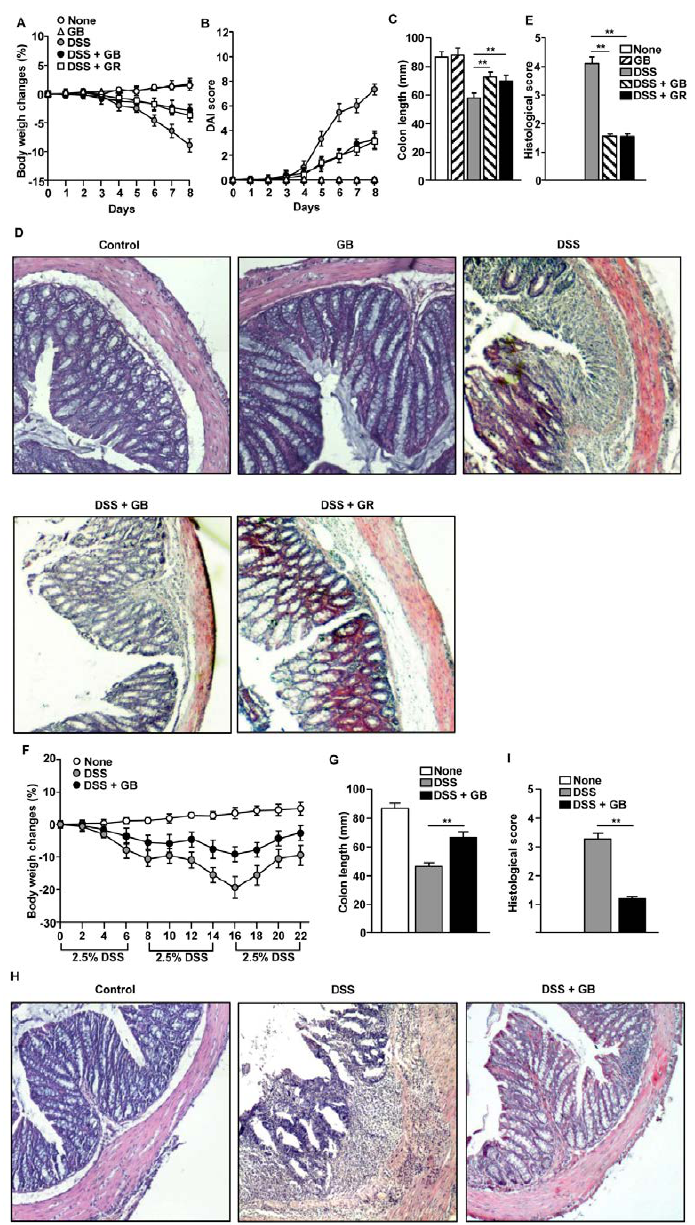
Figure 1. Ginseng berry extract (GB) treatment attenuates DSS-induced colitis. ( A to E ) Dextran sodium sulfate (DSS; 3%) was added to the drinking water of C57BL/6 mice and the mice were orally treated with GB, ginseng root extract (GR) or 0.9% saline for eight days. ( A ) Body weight changes in control (no treatment), GB, DSS, DSS + GB, and DSS + GR groups ( n = 9); ( B ) The disease activity index (DAI) was scored using stool consistency, the presence or absence of fecal blood, and weigh loss; ( C ) Colon length of colitis mice at day 8; ( D ) Hematoxylin and eosin (H & E) staining images are shown at 80 ˆ magnification; ( E ) Histological scores were evaluated by immune cell infiltration and colon damage. Data are the average or representative of analyses of three independent experiments (total n = 9/group); ( F to H ) C57BL/6 mice were given drinking water containing 2.5% DSS for three cycles to induce chronic colitis. Some of the DSS-treated mice also received daily oral administration of GB. Non-treated control mice drank only distilled water. Mice were sacrificed at day 22 and analyzed for disease parameters; ( F ) Body weight changes ( n = 9); ( G ) Colon length; ( H ) Colon sections stained with H & E from three groups of mice at the same magnification (80 ˆ ); ( I ) Histological scores. Data are representative of/or the average of analyses of three independent experiments (total n = 9). Data shown are the mean ˘ SEM. ** p <